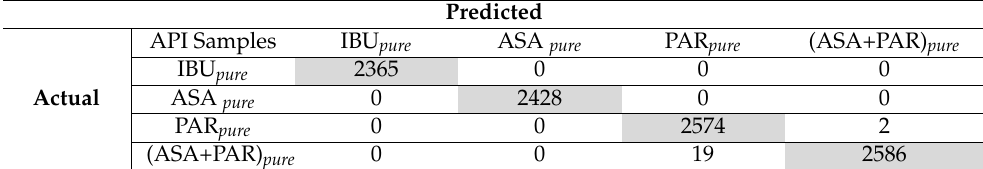
Table 3. The confusion matrix of the pure API spectra.